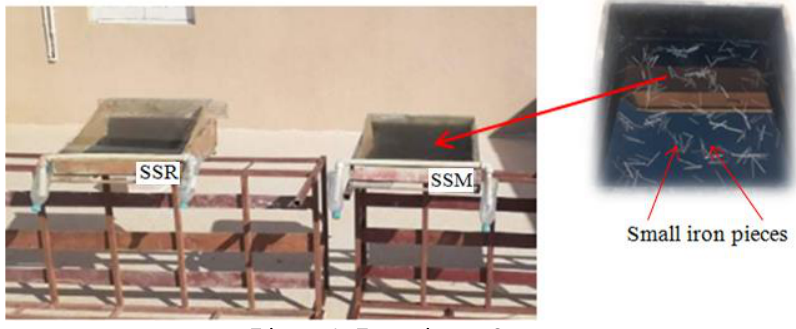
Figure 1. Experiment Setup